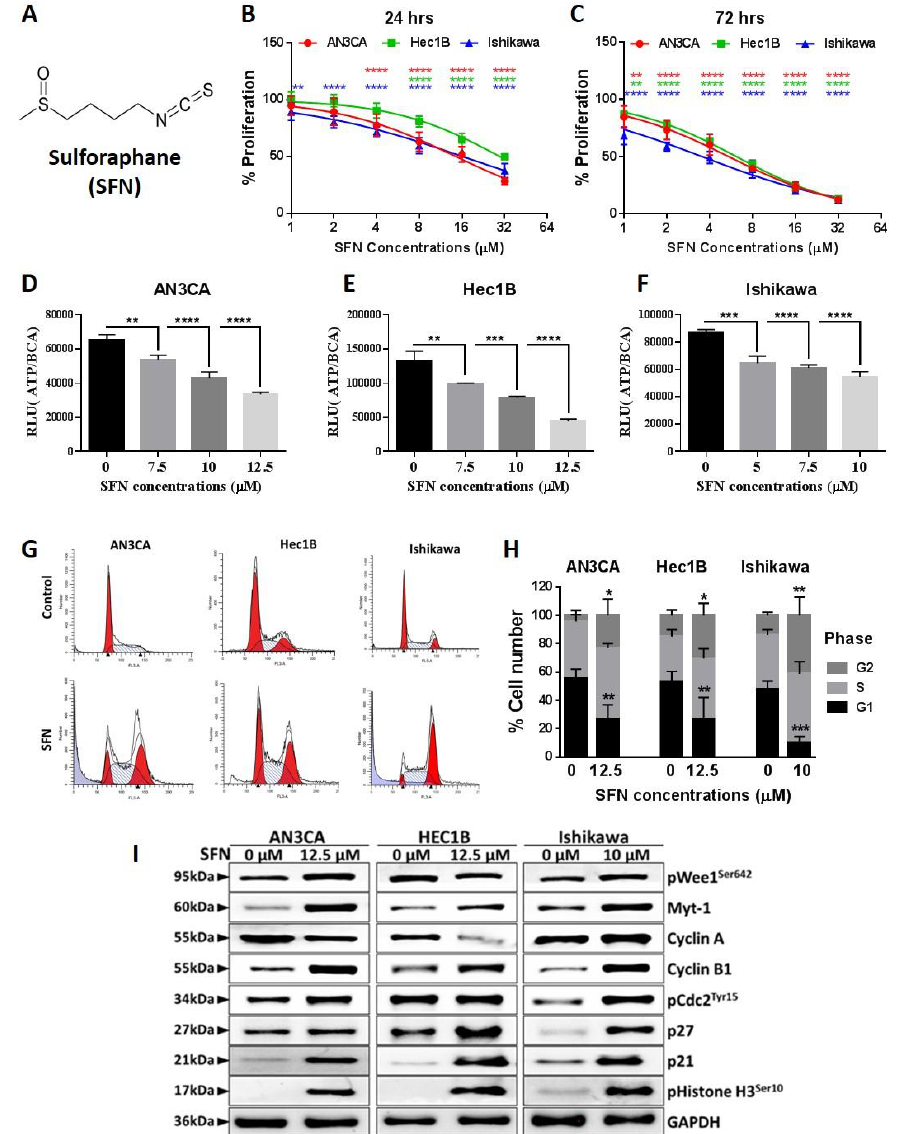
Figure 1. Sulforaphane inhibits endometrial cancer cell viability and induces G 2 / M cell cycle arrest. ( A ) The chemical structure of Sulforaphane. ( B , C ) Endometrial cancer cells were treated with sulforaphane at the indicated concentrations for 24 h ( B ) and 72 h ( C ), and cellular proliferation was assessed using the BrdU (bromodeoxyuridine) ELISA (Enzyme-linked immunosorbent assay). Data are the mean ± SD, and two-way ANOVA was used for statistical analysis. ( D – F ) Adenosine triphosphate (ATP) levels in sulforaphane treated cells at the indicated concentration for 24 h were measured using Cell Titer Glo Assay. Relative luminescence (RLU) data were normalized to the protein level. Data are expressed as mean ± SD and One-way ANOVA was used for statistical analysis. ( G , H ) Endometrial cancer cells were treated with sulforaphane for 24 h, and then cells were stained with propidium iodide and subjected to flow cytometric analysis to determine the cell distribution at each phase of the cell cycle. Representative images of cell cycle distribution with or without sulforaphane were shown ( G ). Percentages of cells at di ff erent cell cycle phases are expressed as mean ± SD of three independent experiments and Two-way ANOVA was used for statistical analysis ( H ). ( I ) Cells were treated with sulforaphane for 24 h, and protein isolates were analyzed by western blot with antibodies against cell cycle associated proteins. Glyceraldehyde 3-phosphate dehydrogenase (GAPDH) was used as a reference protein. “ p ” values are indicated * p ≤ 0.05, ** p ≤ 0.01, ***; p ≤ 0.001, **** p ≤ 0.0001 when compared with respective control. SFN; sulforaphane. The whole western blot images of Figures please find in Figure